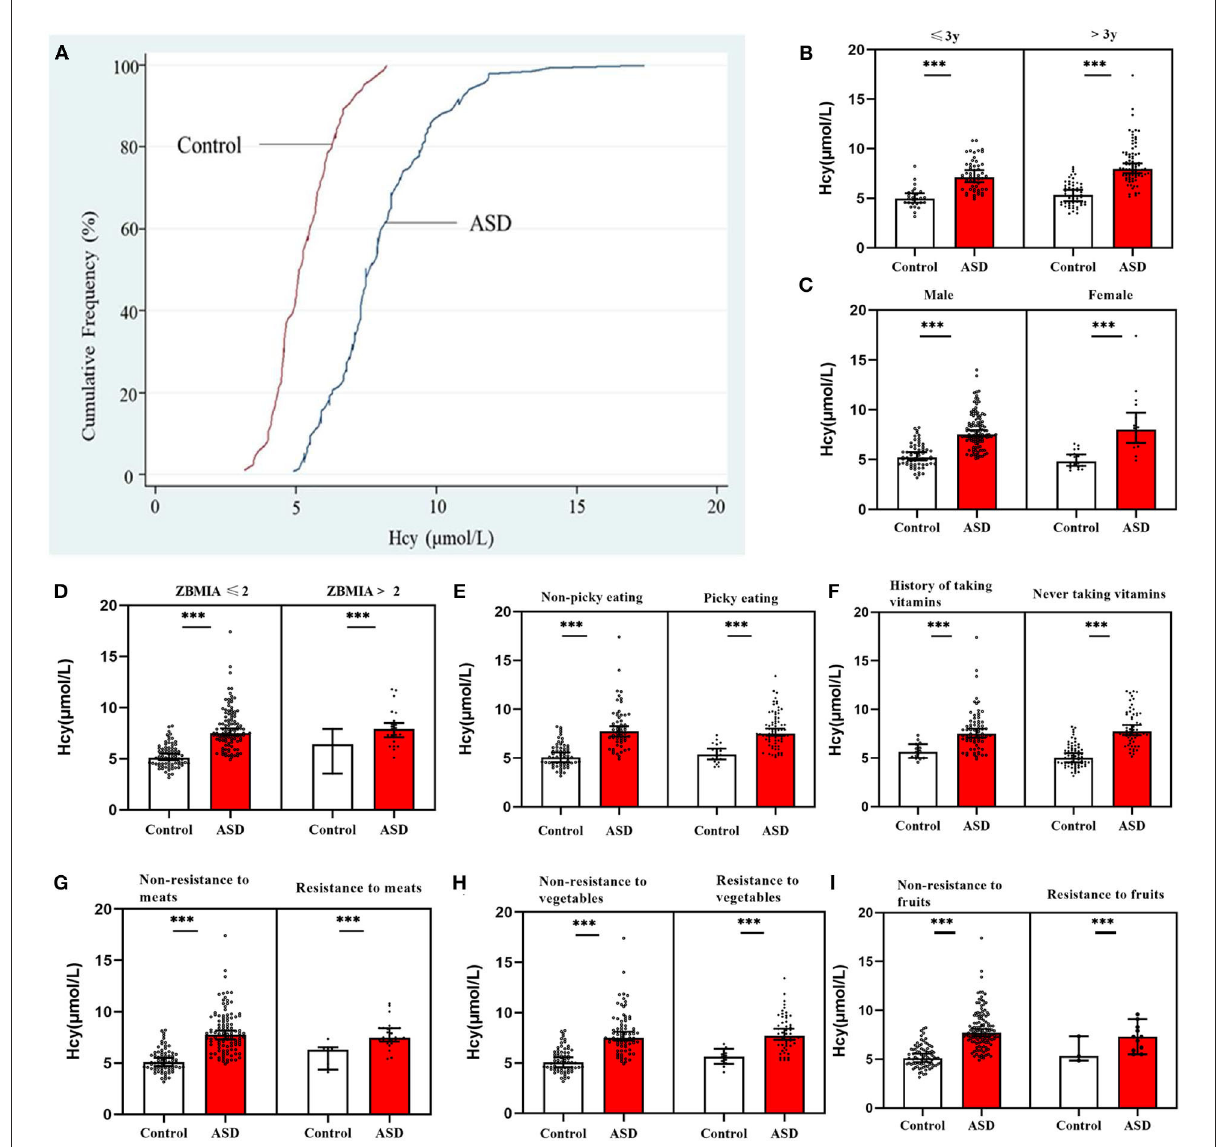
FIGURE3 Serum homocysteine (Hcy) levels in children with ASD and controls. (A) Cumulative frequency distributions of Hcy levels in both groups. (B–I) Serum Hcy levels were stratified by age, sex, BMI, food selectivity, and use of vitamins. In both groups, there were significant differences between serum Hcy levels in children with ASD for each covariate (*** p < 0.001). Hcy, homocysteine; VitB12, vitamin B12.